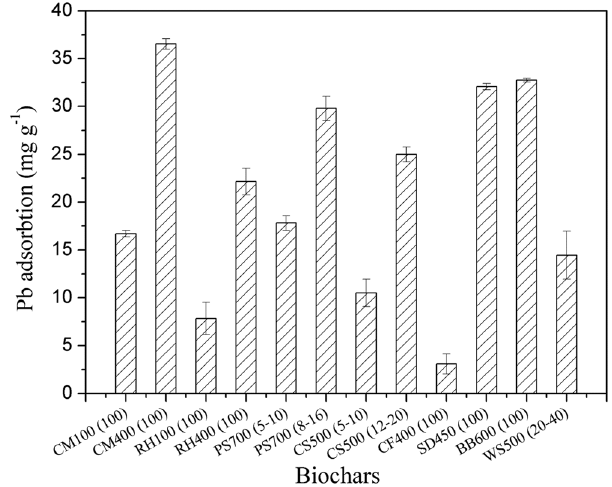
Figure 1. The Pb adsorption amount by different biochars. The capital letters represent the abbreviations of biochar precursors, the number following the letters is the pyrolysis temperature and the number in the bracket is the mesh sieve of biochars being passed through. The initial concentration and pH value were 100 μ mol L − 1 and 3.7, respectively; the biochar loading was 0.25 g L − 1